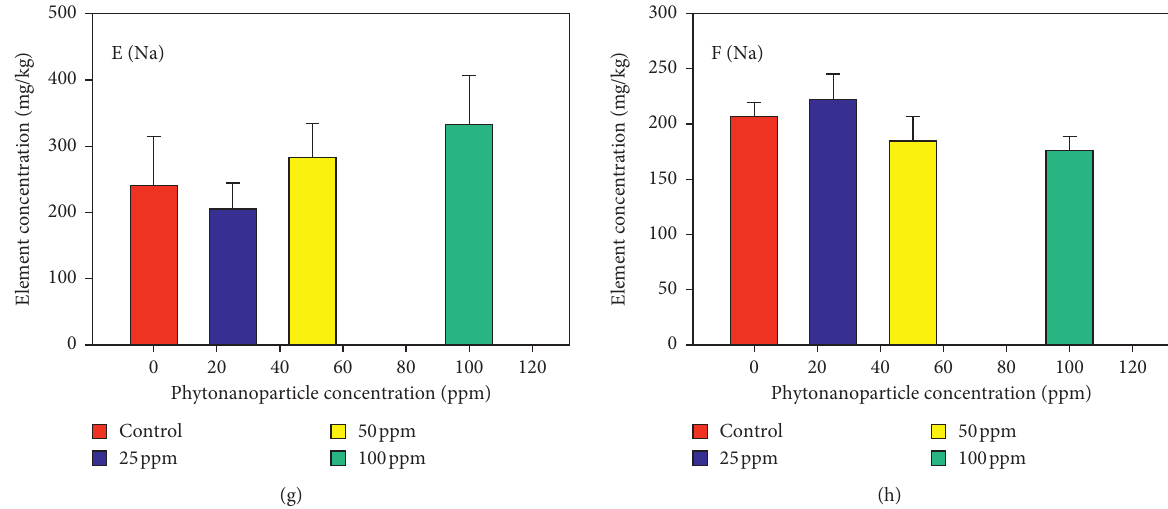
Figure 5: Evaluation of the accumulation of mineral elements in the fruits of tomato plants ( Solanum lycopersicum ) in relation to the effect of ZnO phytonanoparticles with the Moringa oleifer a extract. Mean of three repetitions with ( ± ) standard error. Application: E: edaphic; F: foliar.